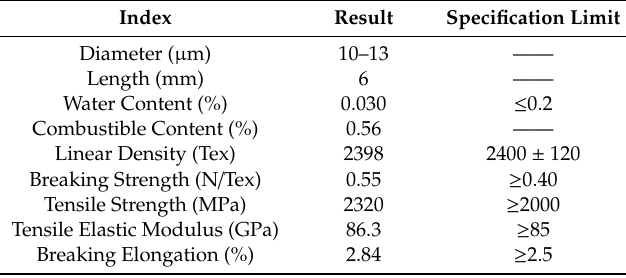
Table 2. Technical index of basalt fiber (BF).